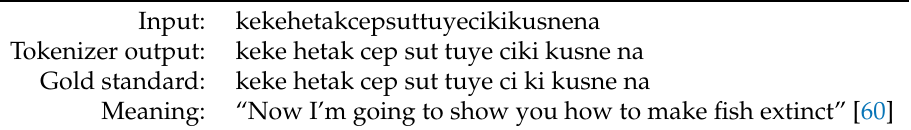
Table 13. A fragment from Y9–13 (M-SR) before and after